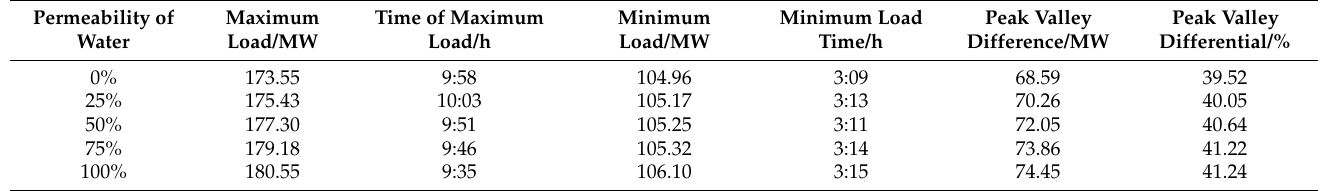
Table 2. Overall load statistics of distribution network under different